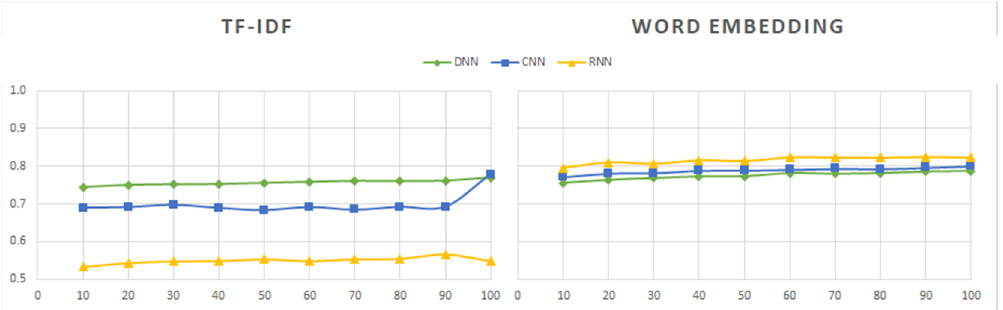
Figure 11. Recall values of DNN, CNN, and RNN models with TF-IDF and word embedding for different numbers of tweets (percentage of the dataset).